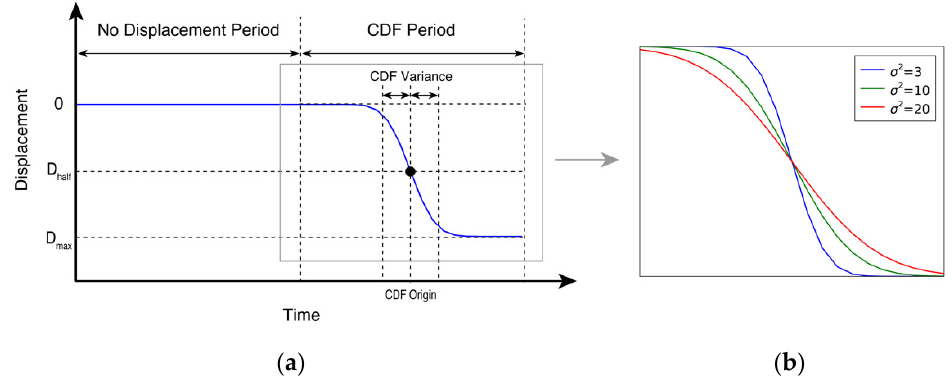
Figure 4. ( a ) The displacement model in the simulation. ( b ) The displacements, with the different cumulative distribution function (CDF) variances in the CDF period shown in ( a ).